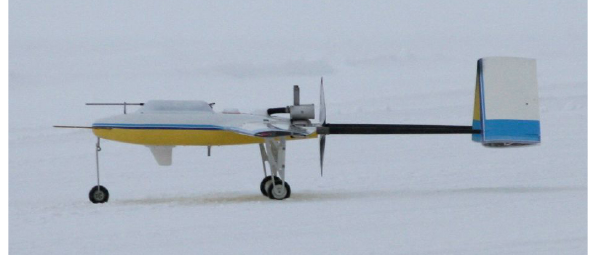
Figure 1. Manta UAS on runway after first landing in Ny-Ålesund. 2 Fig. 1. Manta UAS on runway after first landing in Ny- ˚Alesund. for primary communication. Beyond line of sight communi- cation is through an Iridium SatCom